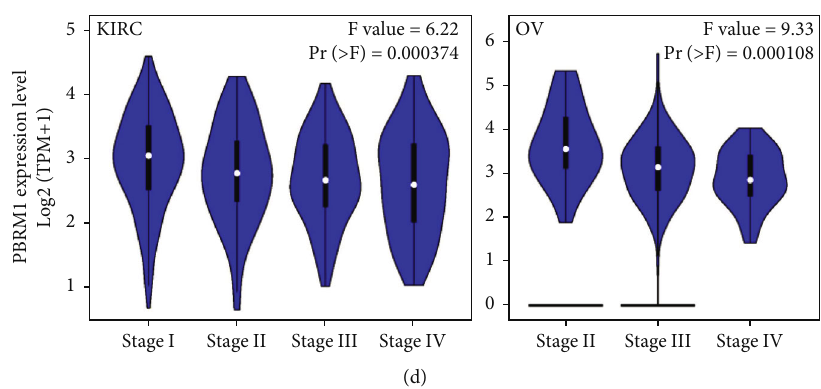
Figure 1: Expressive level and pathological stages of PBRM1 gene in various tumors. (a) The expressive fi gures of the PBRM1 gene in various cancers or targeted cancer subtypes; ∗ P < 0 : 05 , ∗∗ P < 0 : 01 , and ∗∗∗ P < 0 : 001 . (b) In TCGA project, the expressive status of PBRM1 in DLBC, LAML, LGG, and thymus was compared to the related normal systems in GTEx data. ∗ P < 0 : 05 . (c) Based on the CPTAC dataset, researchers also studied the expressive level of PBRM1 total protein between normal tissue and primary tissue of RCC, UCEC, COAD, OV, LIHC, GBM, PAAD, and LUAD. (d) According to TCGA data, PBRM1 gene expression level was analyzed according to the main pathological stages of KIRC and OV (stages I, II, III, and IV). Log ( TPM + 1 ) is used for the logarithmic 2